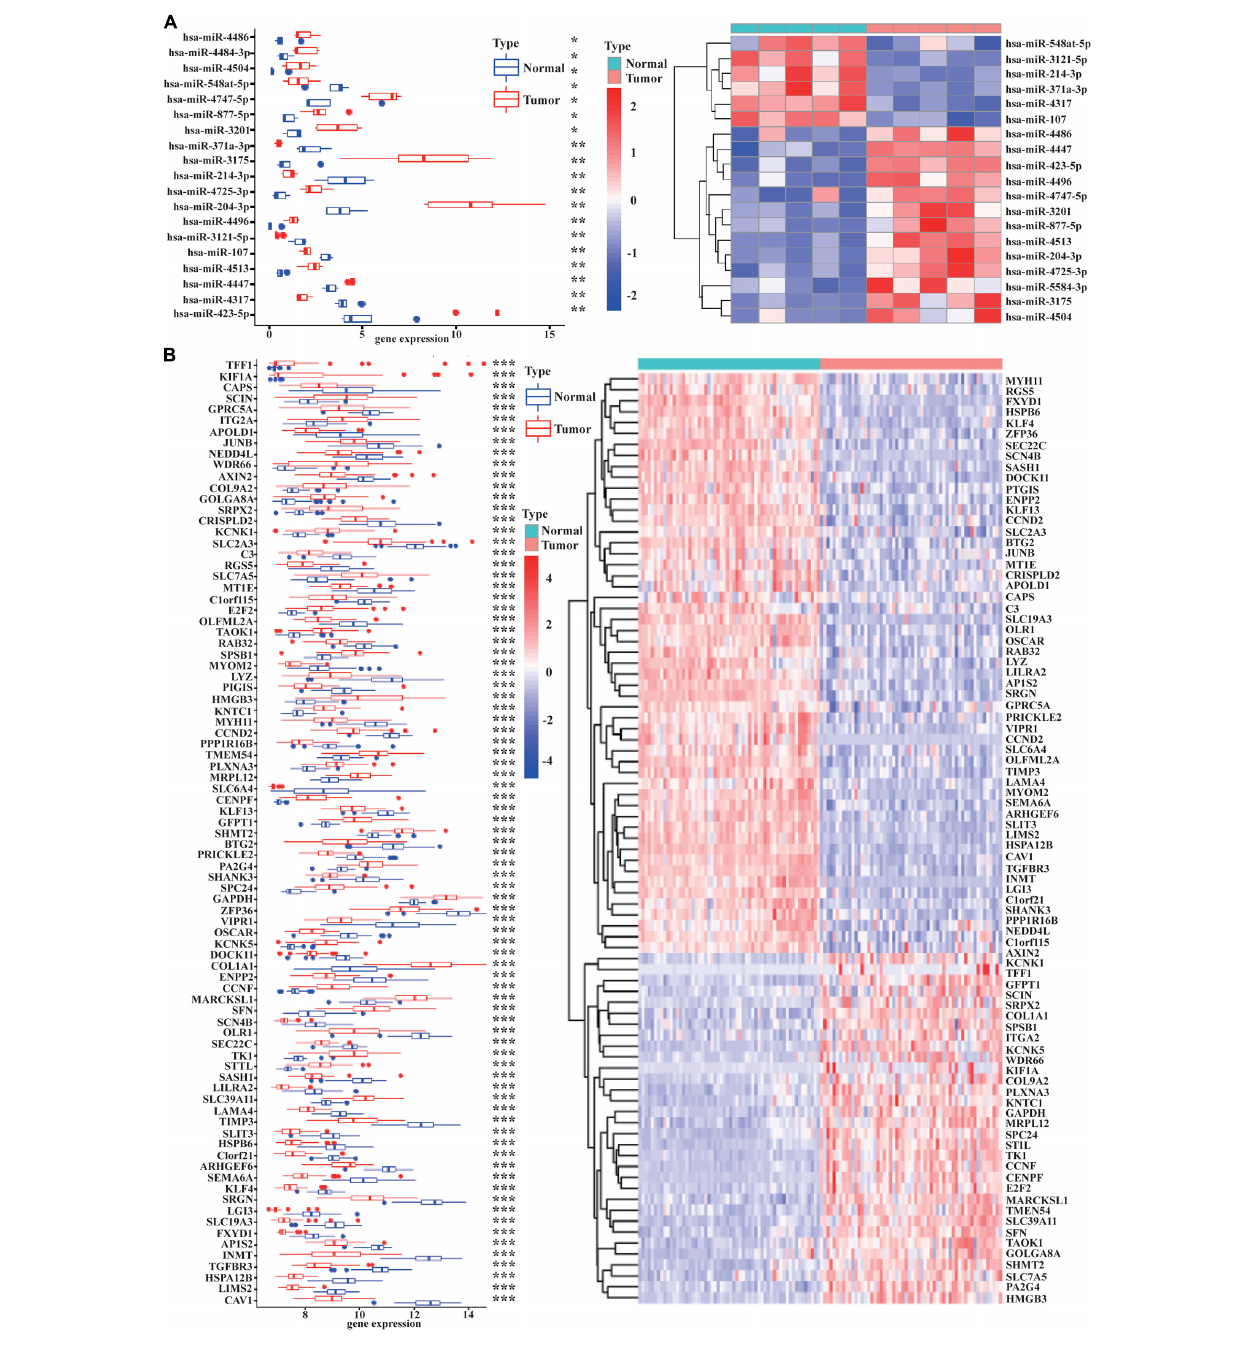
FIGURE 4 | The 19 overlapped DEmiRNAs and the 85 overlapped DEmRNAs. The boxplot and heatmap of the 19 overlapped DEmiRNAs are shown in (A) . The 19 DEmiRNAs were selected through overlapping the 441 miRNAs binding to the 8 DEcircRNAs and the 237 DEmiRNAs identified in GSE135918. The expression levels of the 19 overlapped DEmiRNAs are described in (A) . The boxplot and heatmap of the 85 overlapped DEmRNAs are shown in (B) . The 85 DEmiRNAs were obtained by overlapping the 2,775 target genes binding to the 19 DEmiRNAs and the 956 DEmRNAs identified in GSE32863. The expression levels of the 85 overlapped DEmRNAs are displayed in (B) . [| log2(fold change)| > 1 and p < 0.05 were the cutoff criteria]. * p < 0.05, ** p < 0.01, *** p < 0.001.